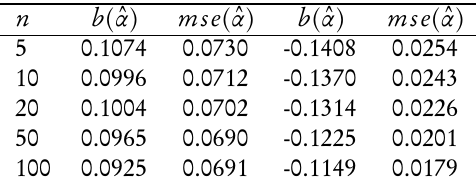
Bias and mean square error of the m.l.e. ˆ α , for the power uniform distribution { r m − 1 = 10 , α = 4.35 , and α = 0.45